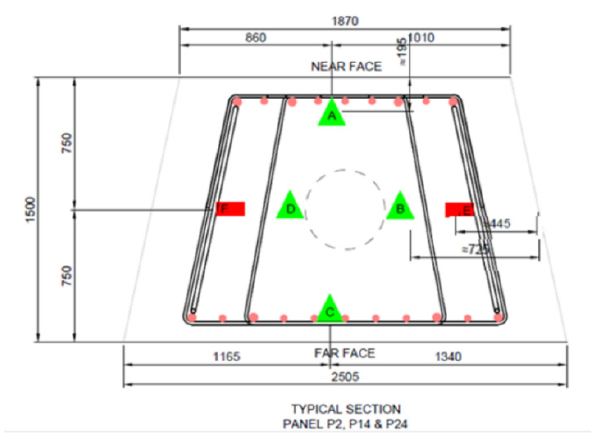
Figure 4: Location of gauges in instrumented panels (Sajadi,